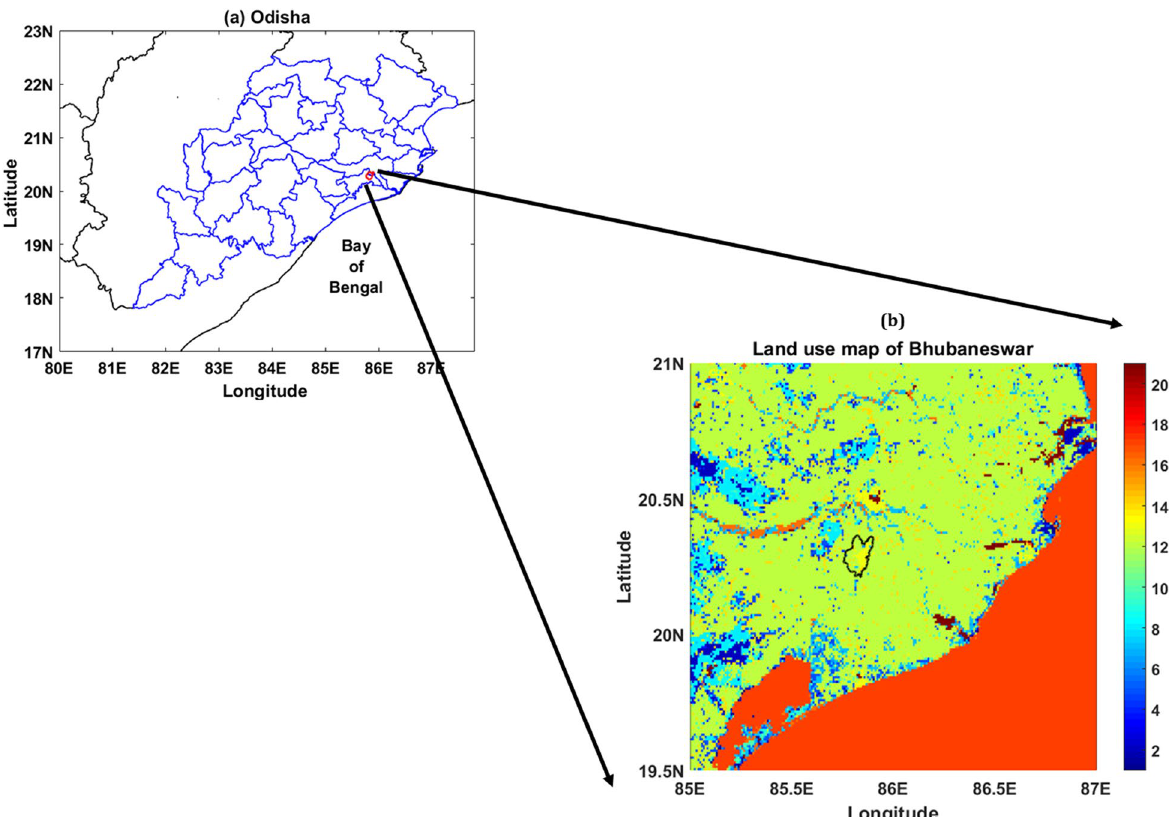
Fig. 1 Study area showing ( a ) the east coast state of Odisha and the location of the capital city Bhubaneswar; b municipal boundary of the city, with the numbers indicating the landmarks across Bhubaneswar city (names are in the table shown left side to the image) discussed in the